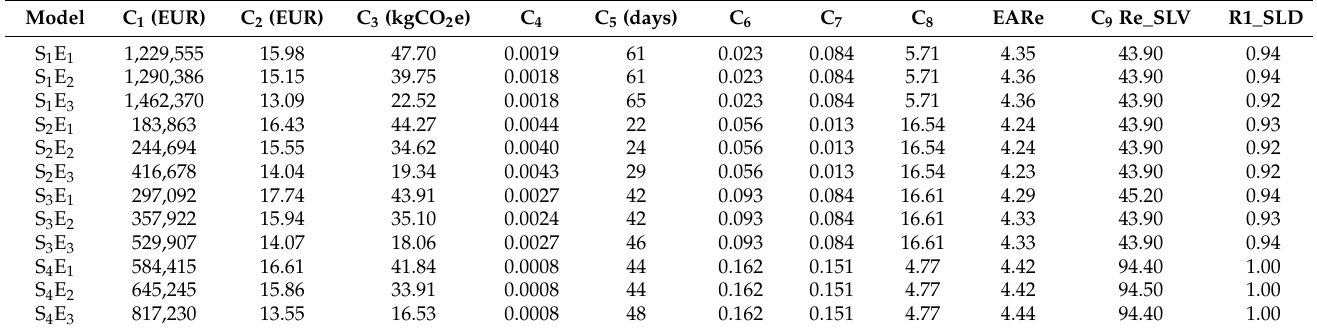
Table 6. Decision variable values adopted from [30] and using three different seismic resilience parameters.